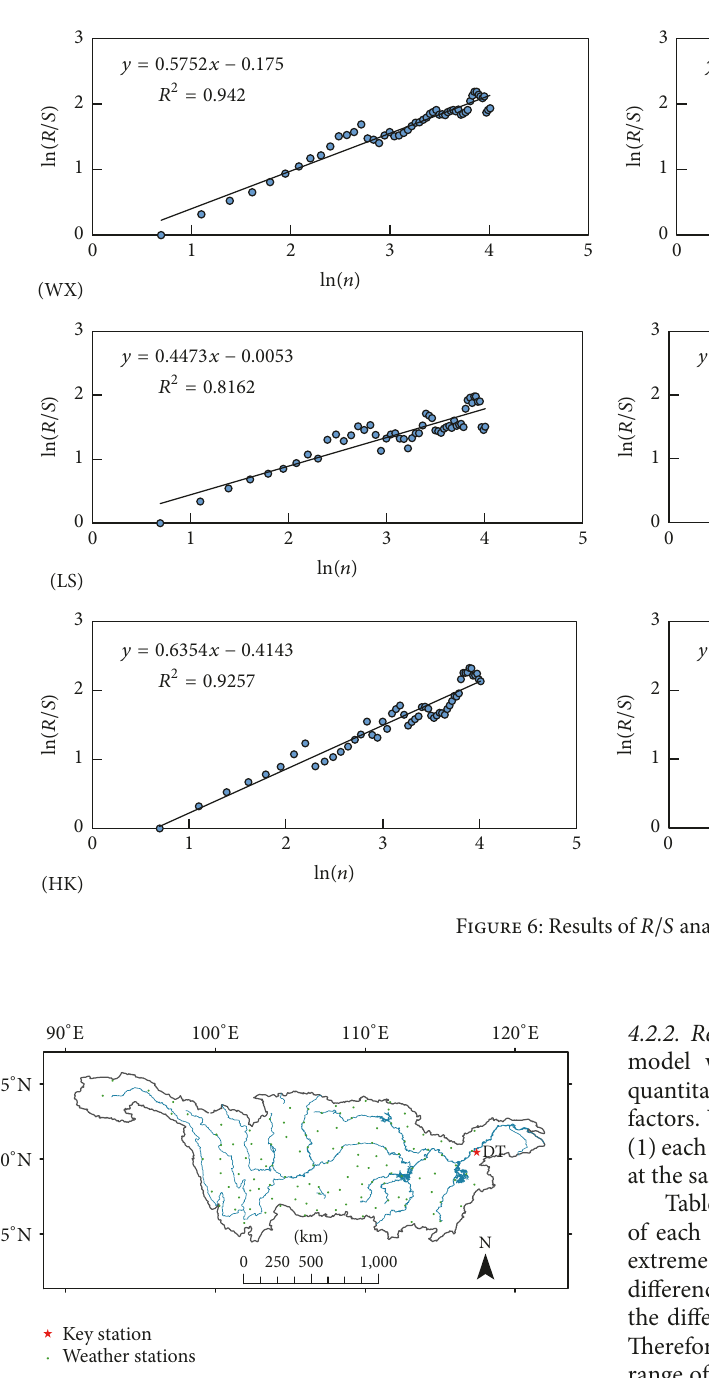
Figure 7: Study hydrological station, DT station, and its 122 weather